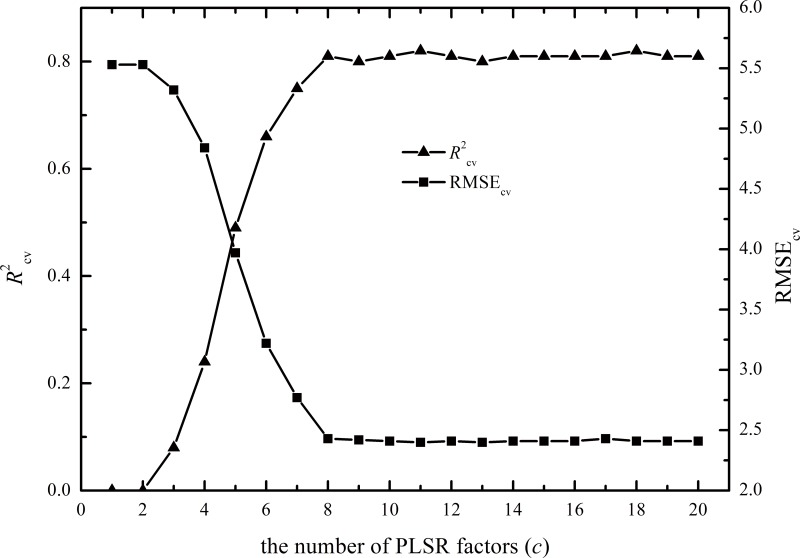
Parameters of the PLSR calibration model.